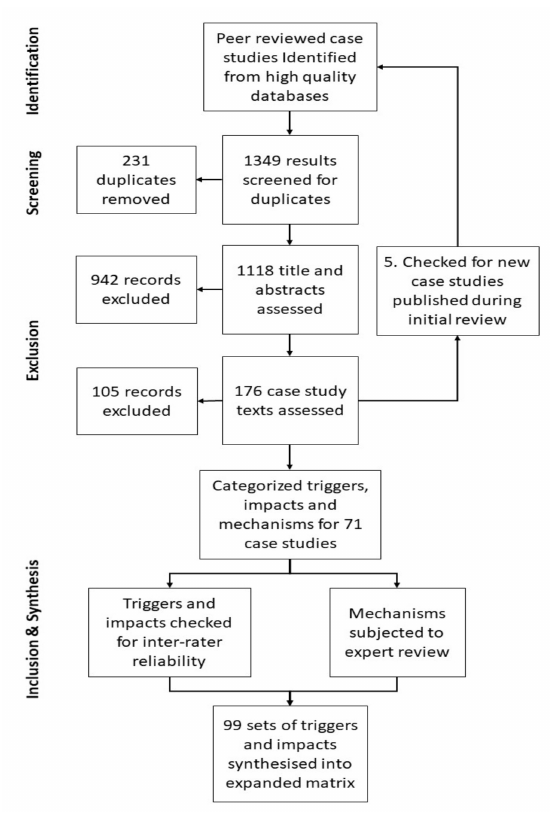
Figure 3. Progression through the systematic literature review